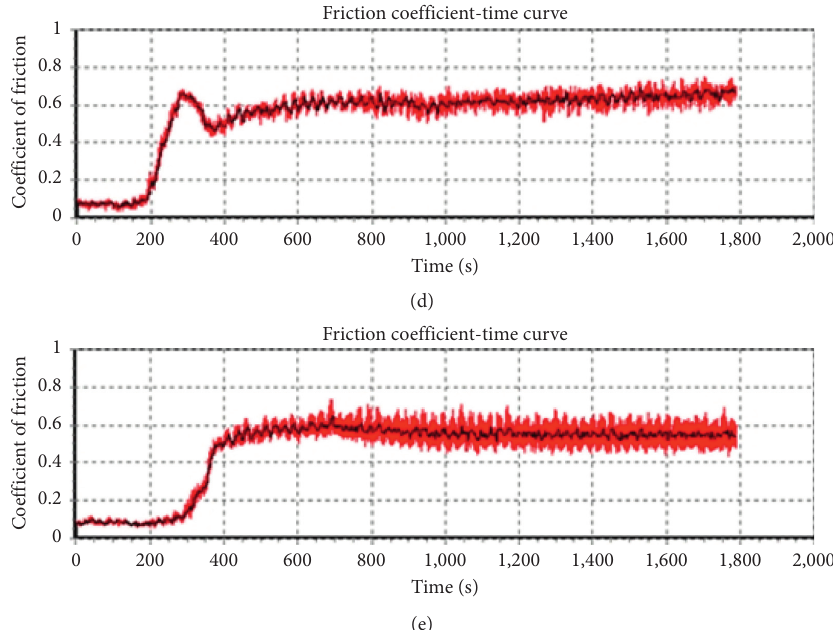
Figure 12: The relationship between friction coefficient and time under different loads: (a) 20N, (b) 25N, (c) 30N, (d) 35 N, and (e)